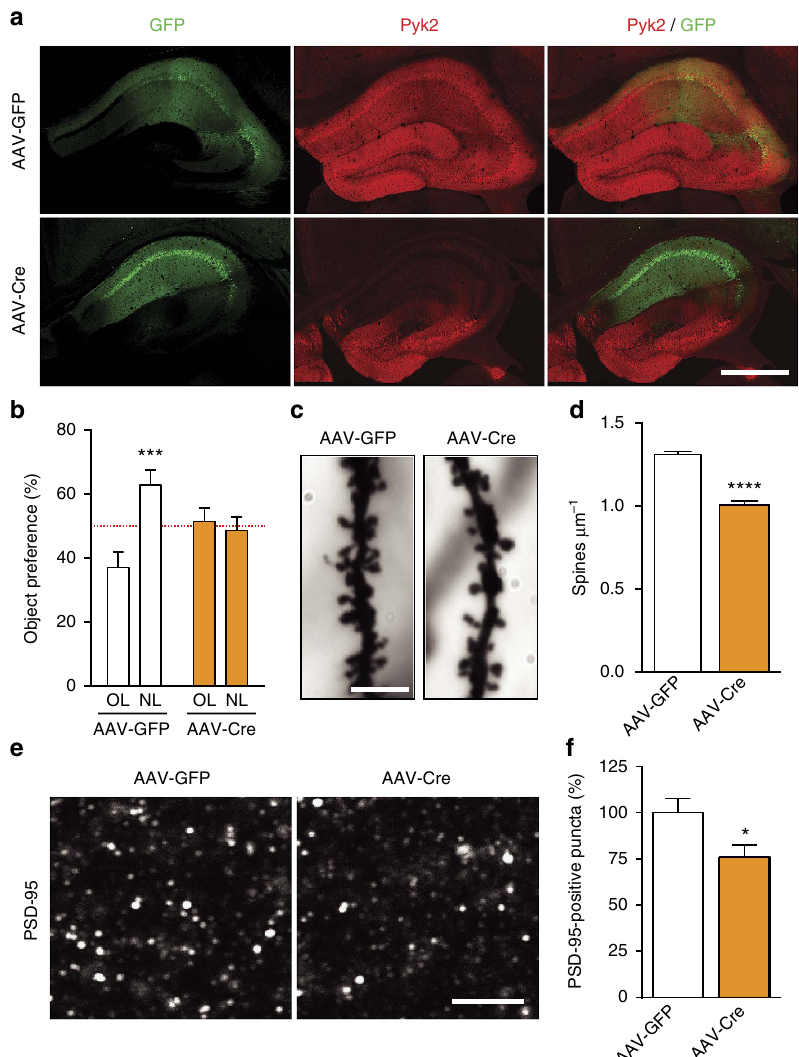
Figure 4 | Pyk2 ablation in CA1 from adult mice induces spatial learning deficits and spine alterations. ( a ) Mice with floxed Pyk2 alleles (Pyk2 f/f , 4- week-old) were bilaterally injected in dorsal hippocampus CA1 with AAVexpressing GFP (AAV-GFP) or GFP-Cre (AAV-Cre). GFP fluorescence (green) and Pyk2 immunoreactivity (red) were detected with confocal microscope (stitched pictures). With both viruses widespread, GFP expression is present in CA1 and Pyk2 is reduced in CA1 of AAV-Cre-injected mice. Scale bar, 200 m m. ( b ) AAV-GFP and AAV-Cre mice were subjected to the NOL test as in Fig. 1b and the percentage of time exploring the displaced object (NL) compared to that exploring the unmoved object (OL). Two-way ANOVA interaction F (1,44) ¼ 9.94, P ¼ 0.003, OL versus NL Holm-Sidak’s test, AAV-GFP, t ¼ 4.0, P o 0.001, AAV-Cre, t ¼ 0.45, ns (12 mice per group). The red dotted line indicates the chance level. ( c ) Representative Golgi-Cox-stained apical dendrites from CA1 pyramidal neurons of AAV-GFP and AAV-Cre mice. Scale bar, 4 m m. ( d ) Quantification of spine density in dendrites stained as in c , 81–86 dendrites from four mice per genotype. Student’s t -test t 165 ¼ 10.1, P o 10 (cid:2) 4